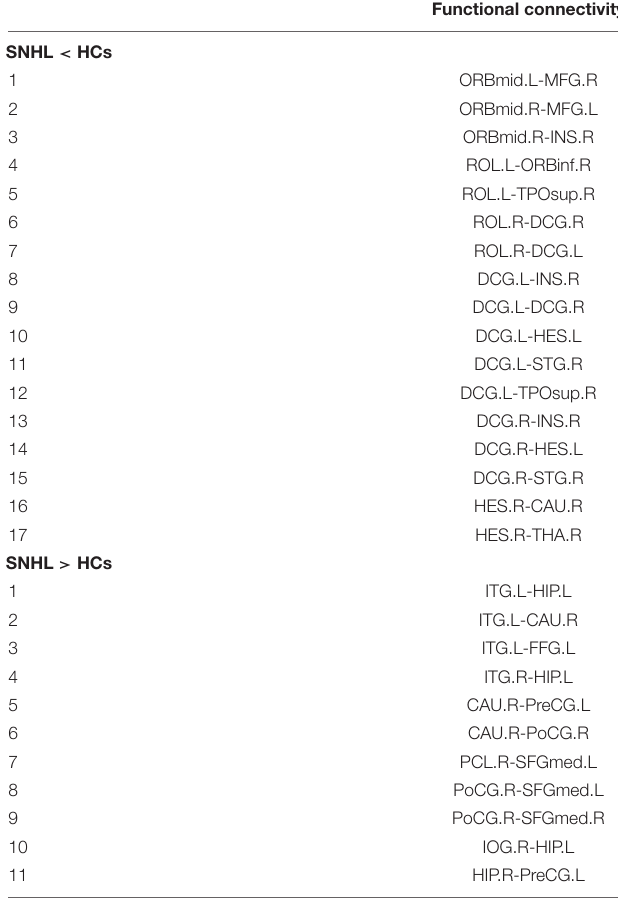
Functional connectivity